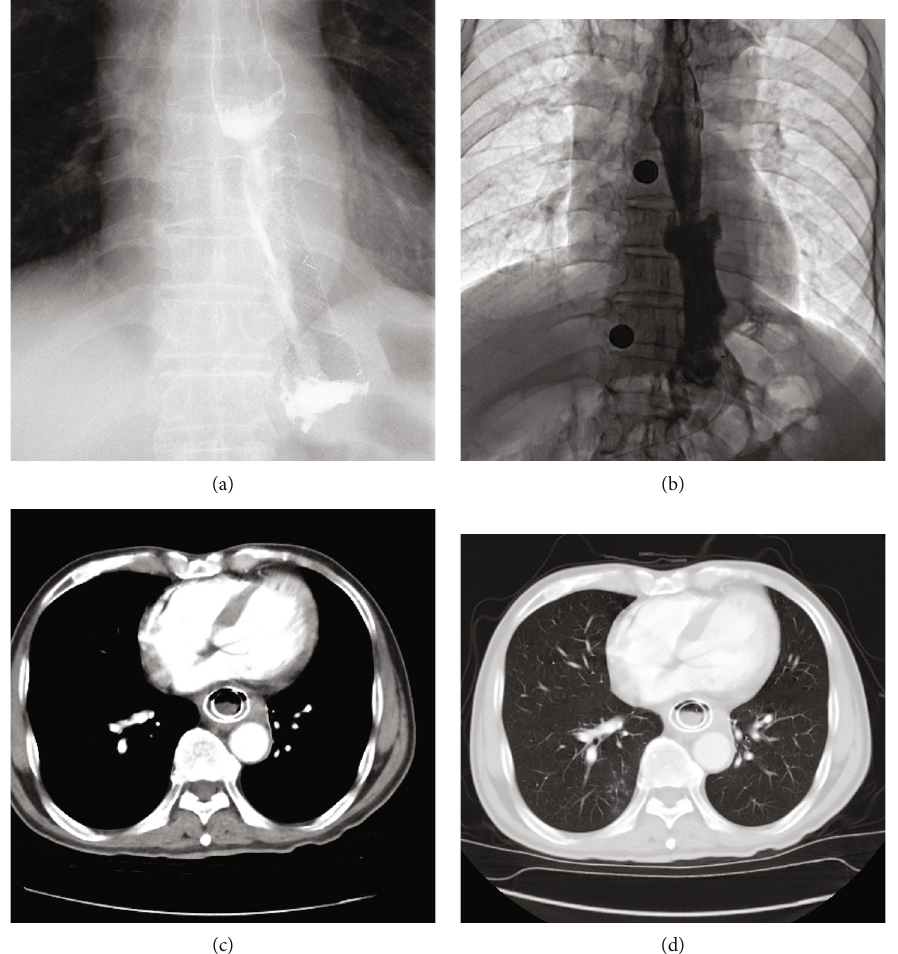
Figure 5: Additional stent placement for restenosis of stent (case 12). (a) Esophagography showed severe restenosis in the proximal end of stent 5 months later. (b) Another covered stent was inserted to relief restenosis. (c, d) A chest CT scan showed well expansion of stent and relief of